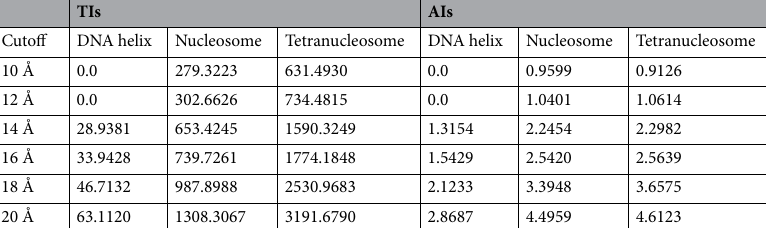
TIs AIs Cutoff DNA helix Nucleosome Tetranucleosome DNA helix Nucleosome Tetranucleosome 10 Å